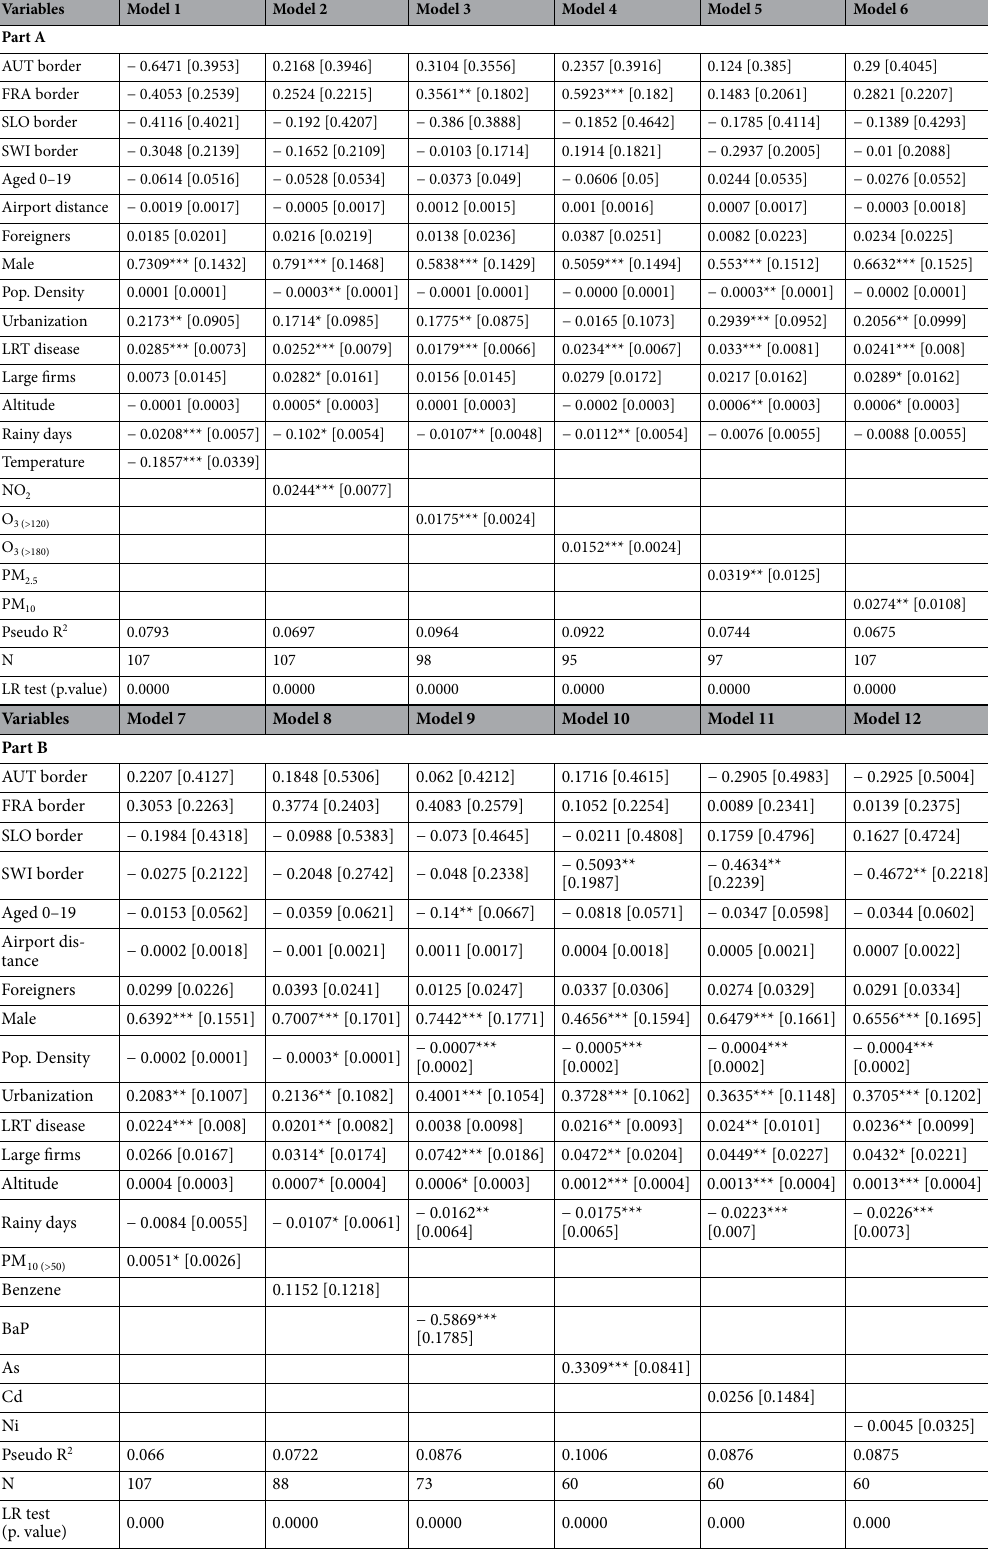
Table 7. Results from negative binomial regressions on COVID-19 cumulative excess deaths registered on 30 November 2020. p-value < 0.01***; p-value < 0.05**; p-value < 0.1*. Standard errors in parentheses. All models included a constant, a dummy for regional capitals, and controls for the size of the province, smokers, and obese